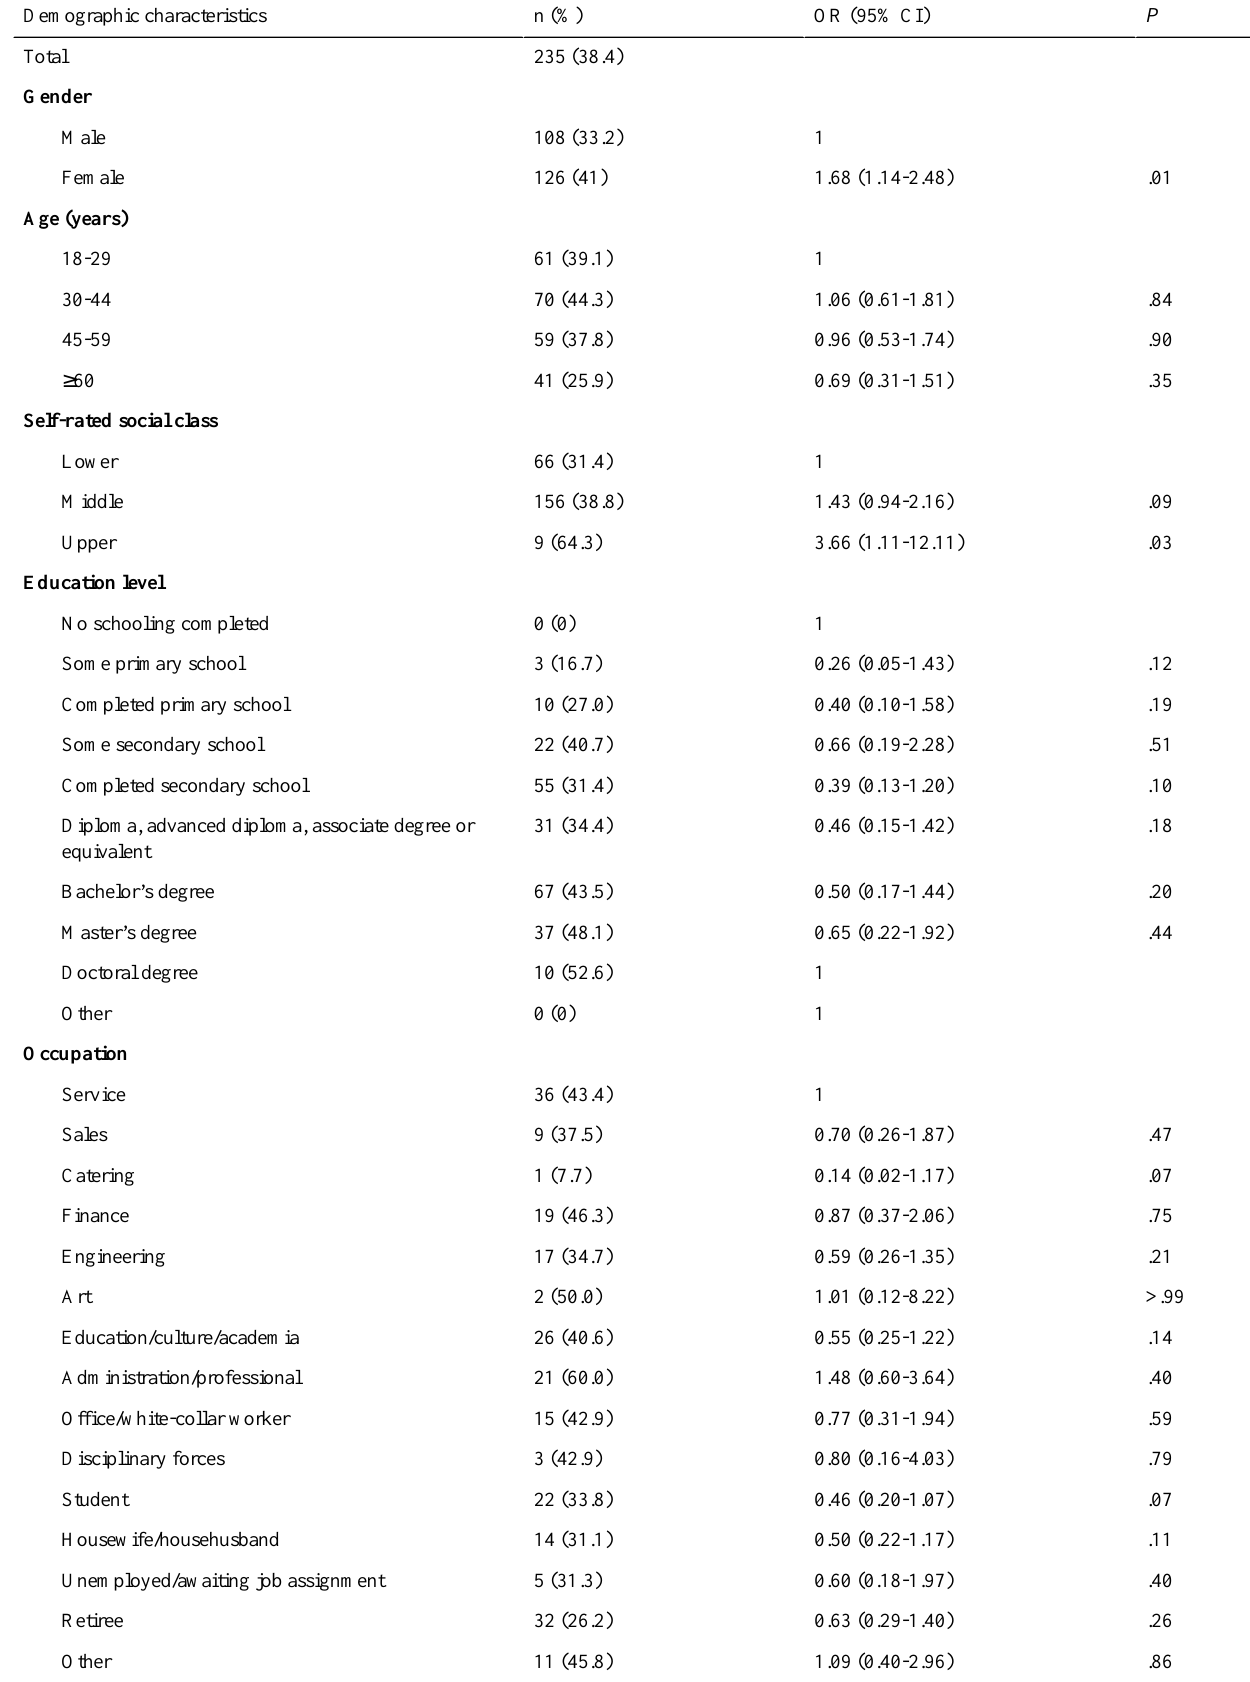
Table 3. Prevalence and demographic correlates of use of any type of health app (N=612). OR: odds